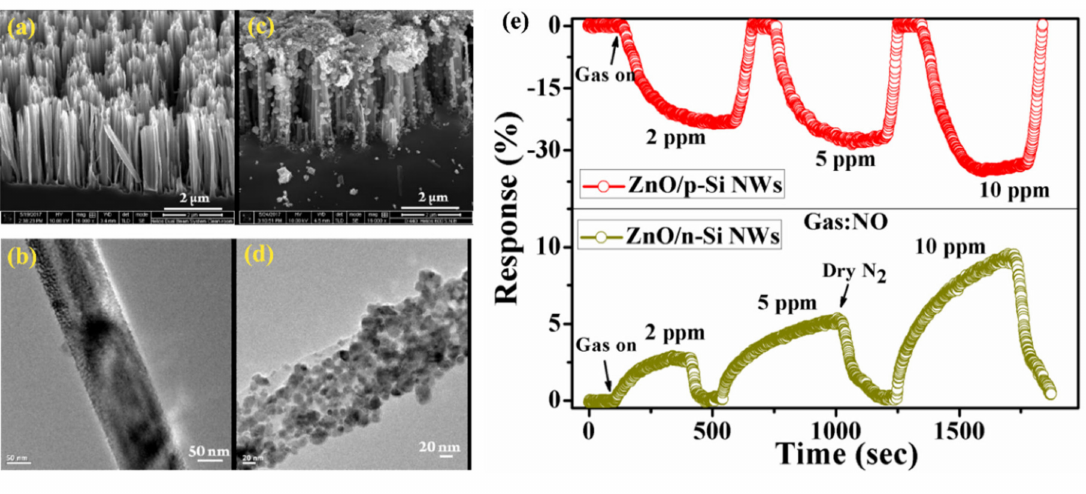
Figure 19. SEM and TEM images of SiNWs before ( a , b ) and after ( c , d ) ZnO deposition; ( e ) response of SiNWs / ZnO heterojunction to NO at RT in N 2 atmosphere for both n and p-type SiNWs. Reproduced from [158], with permission from IOP Publishing,